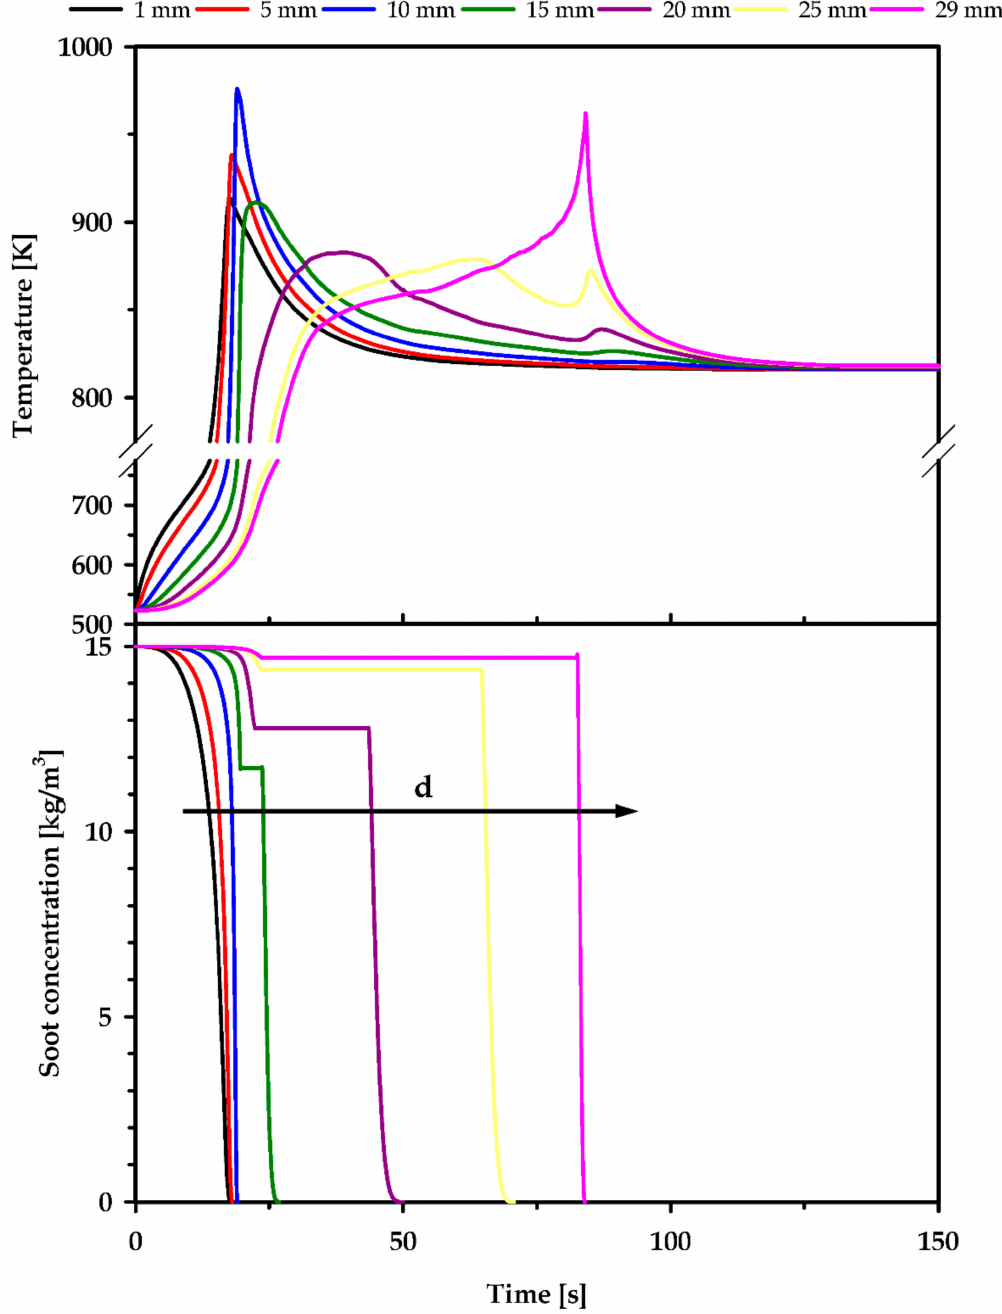
Figure 6. Time histories of temperature and soot concentration (monitor points of Figure 2): k = 100. The arrow indicates the direction of propagation of the reaction front: d = downstream propagation (from upstream—1 mm-to downstream—29